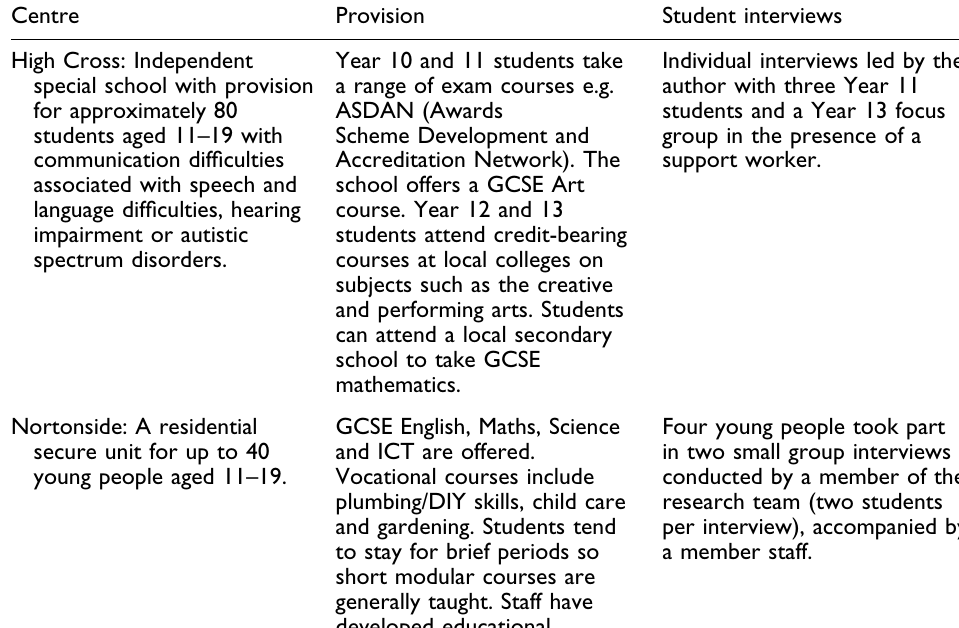
Table 1. The four special centres participating in this study, and students interviewed/observed.